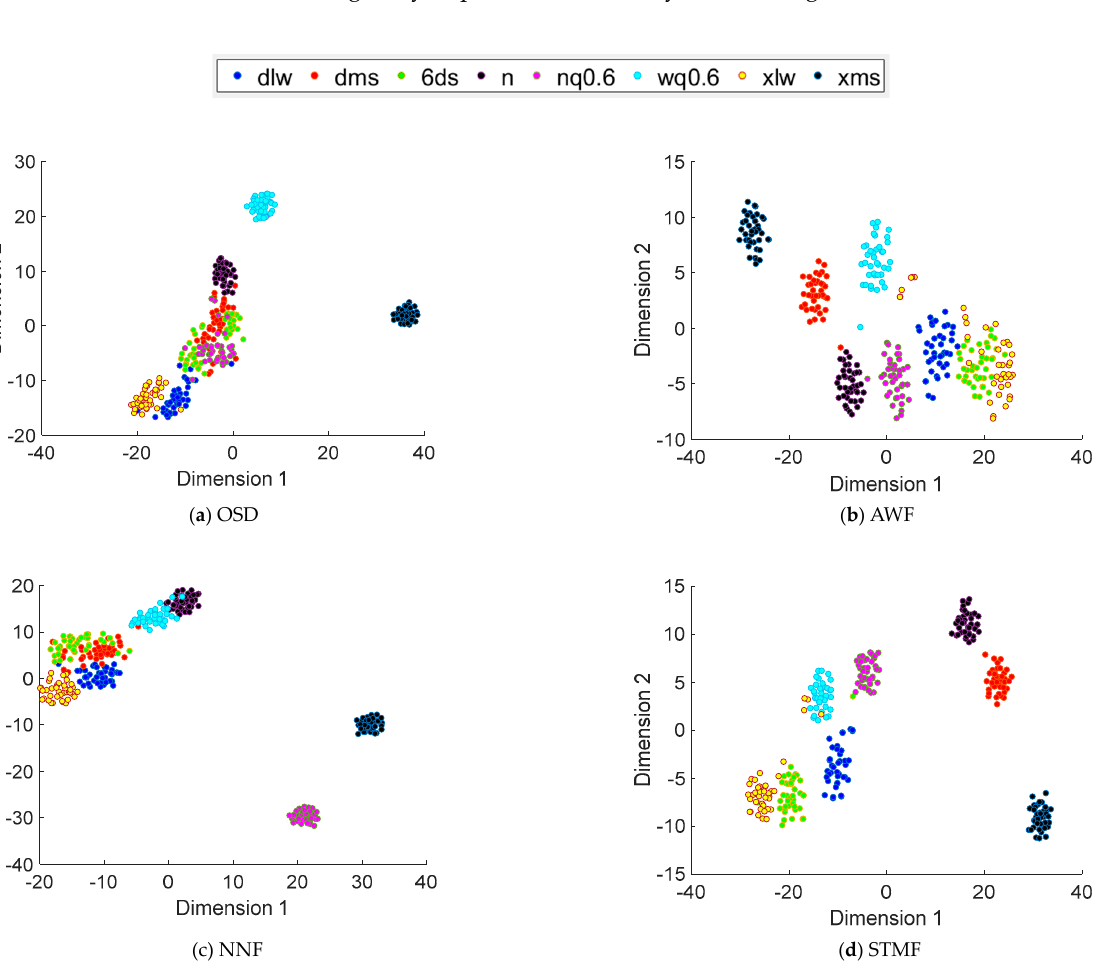
Figure 12. Comparison of eight types of fault classification results under 1100 rpm.